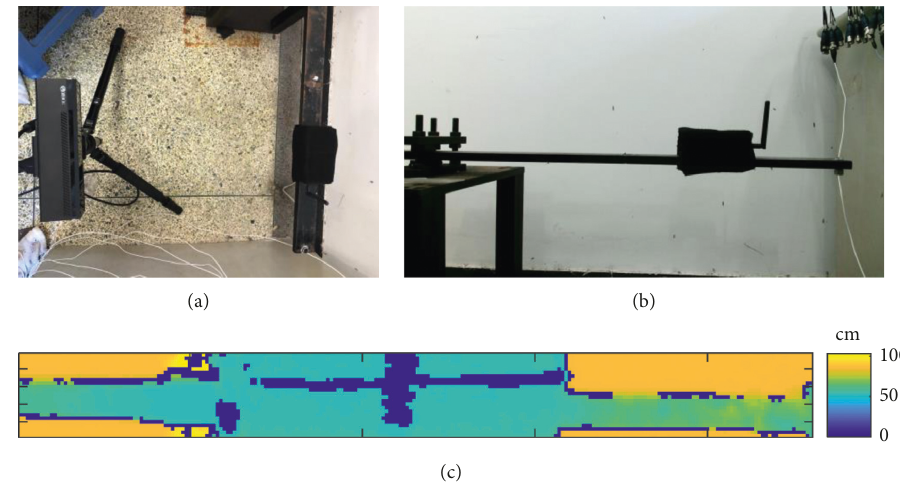
Figure 8: Cantilever steel beam experimental setup for case 2. (a) Vibrometer attached at the end of the cantilever steel beam, Kinect pointing in a direction perpendicular to the direction of vibration. (b) Field of view (FOV) of Kinect in the RGB image. (c) ROI raw depth information visualization.